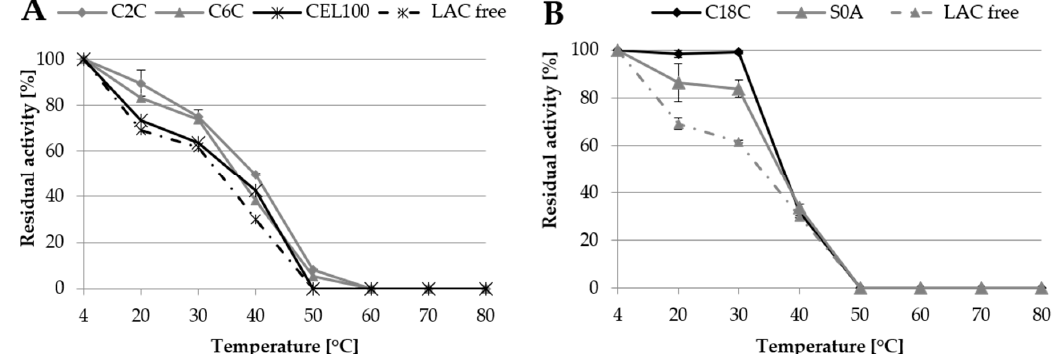
Figure 7. Thermostability of laccase immobilised covalently ( A ) and via adsorption ( B ) in comparison to thermostability of free laccase (LAC free).